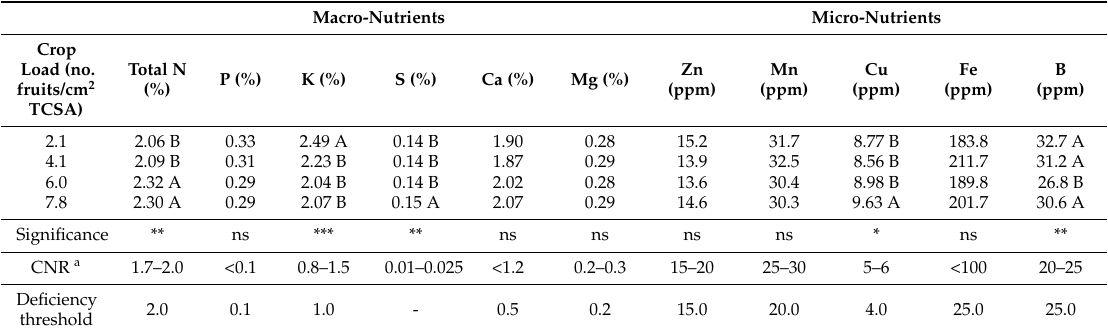
Table 5. The effects of crop load on leaf mineral composition (macro- and micro-nutrients) in leaves sampled from “WA38” trees in the summer of 2017 in Washington State, Wenatchee area. Macro-Nutrients Micro-Nutrients Crop Load (no.